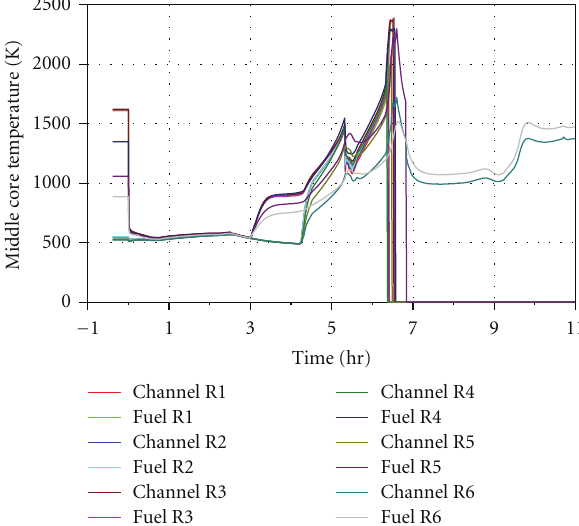
Figure 21: Temperature of fuel and coolant channels in R1 to R6 of mid